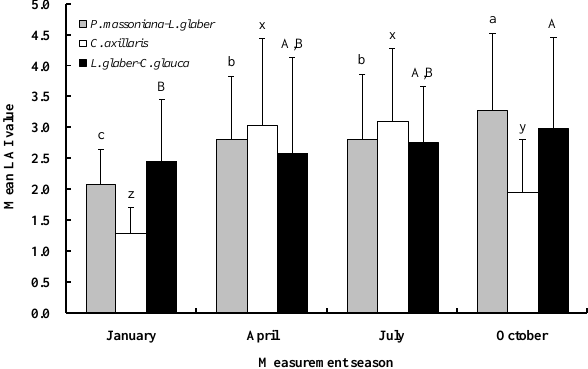
Figure 1. Seasonal variation in mean LAI value (with standard de- viation) in P. massoniana – L. glaber , C. axillaris , and L. glaber – C. glauca forests. The different letters by values indicate significant differences ( P <0.05) among measurement seasons in a given for-